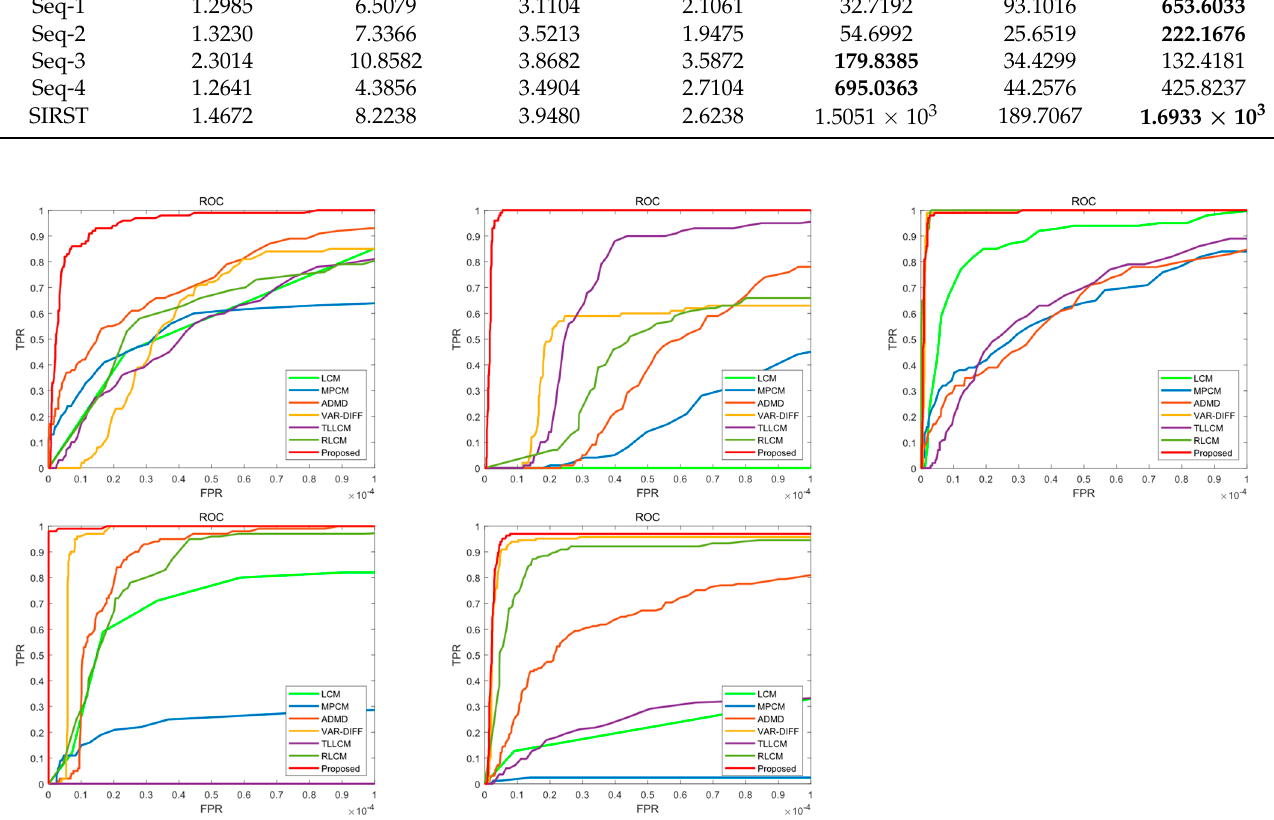
Figure 5. ROC curves of the four sequences and SIRST.